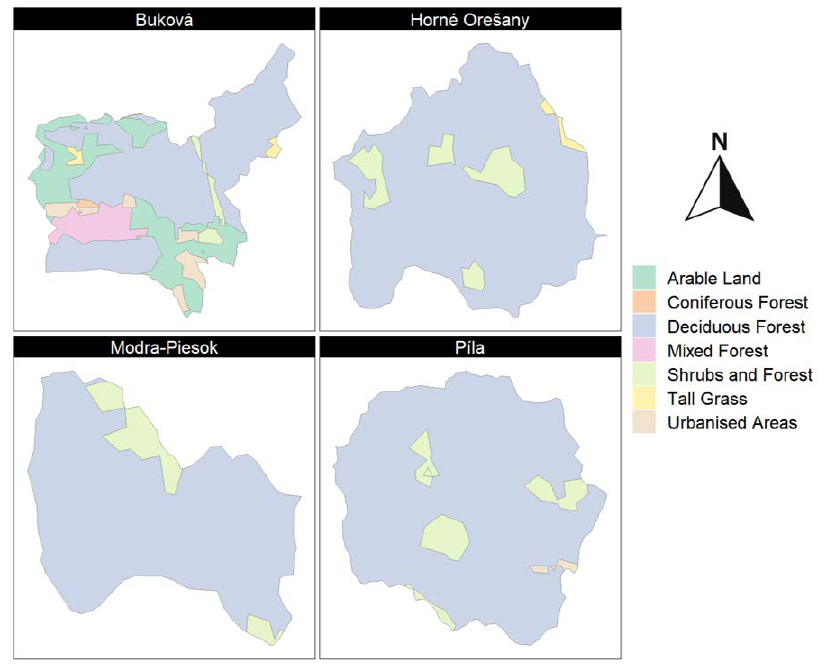
Figure 11. Land use in the catchments under consideration. Table 4. Percentage of areas of land use in the catchments under consideration. Characteristics